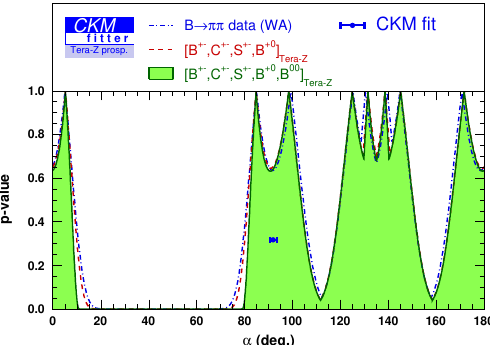
Figure 20 . p -value for α from B → ππ measurements using current data (dotted-dashed blue), improving only charged modes (dashed red), and improving also neutral modes (only BR, solid green) but without additional information on neither a 00